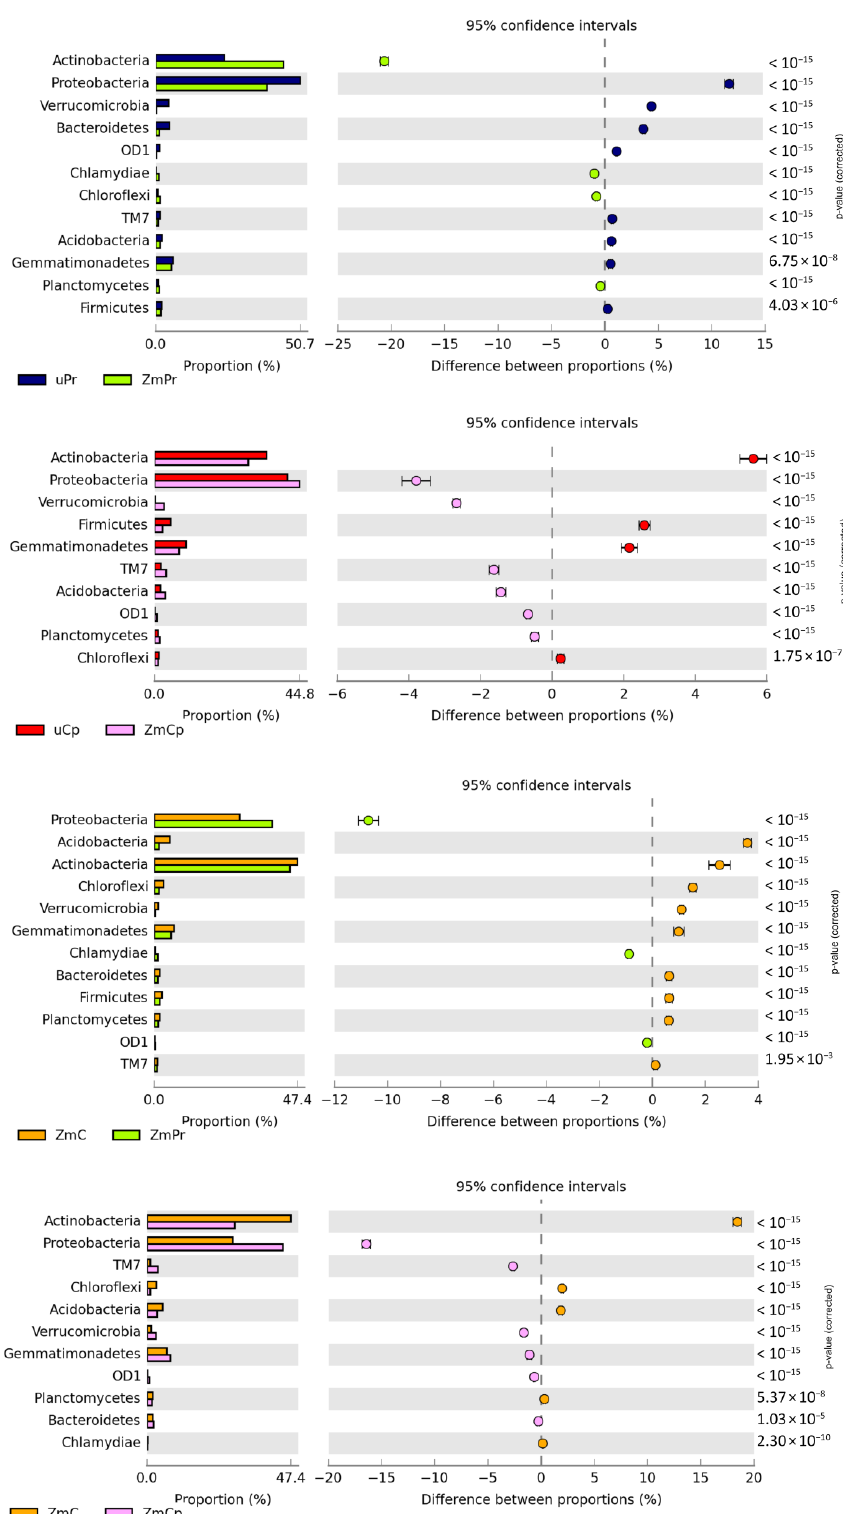
Figure 5. Relative abundance of dominant phylum bacteria in the soil. uC — contaminated unsown soil; uPr — sown soil contaminated with permethrin; uCp — sown soil contaminated with cyperme- thrin; ZmC — uncontaminated soil sown with Zea mays ; ZmPr — soil sown with Zea mays contami- nated with permethrin; ZmCp — soil sown with Zea mays contaminated with cypermethrin. The genera prevailing in the analyzed soil samples regardless of soil utilization and contamination with insecticides, determined based on the average OTU number, turned out to be Cellulosimicrobium , Kaistobacter , Pseudomonas , Sphingomonas , Thermomonas , Devosia , Rhodoplanes , Terracoccus , Bacillus , Rhodanobacter, and Arthrobacter . However, in the bare soil not contaminated with insecticides, the highest OTU numbers were determined for Cellulosimicrobium and Sphingomonas ; in the soil contaminated with permethrin, for Pseudomonas and Cellulosimicrobium ; and in the soil contaminated with cypermethrin, for Cellulosimicrobium , Kaistobacter , and Sphingomonas . In the soil cropped with Zea mays and not contaminated with insecticides, the prevailing phyla turned out to be Cellulosimicro- bium and Arthrobacter . In the sown soil, permethrin and cypermethrin decreased the OTU number of Arthrobacter , whereas permethrin increased the OTU number of Cellulosimicro- bium . In the unsown soil, both insecticides decreased the OTU number of bacteria from the genus Cellulosimicrobium (Figure 6).